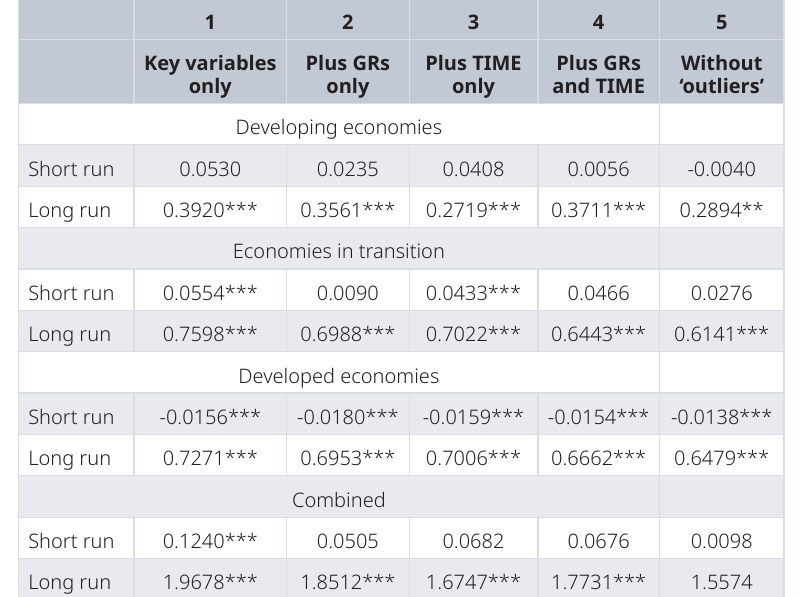
Table 6. Results of the sensitivity of short- and long-run effects to changes in variables and